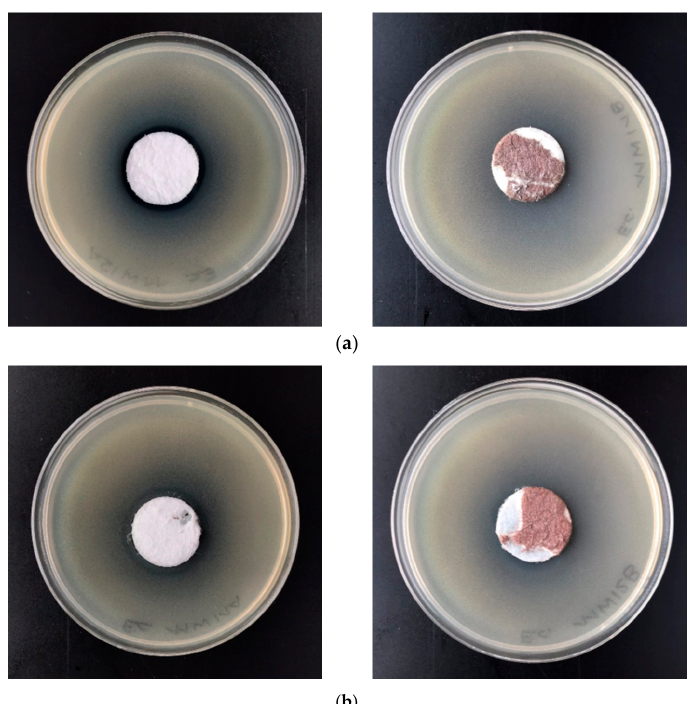
Figure 6. Inhibition zones of bacterial growth on Petri dishes, PLA–Cu 0 (10) sample: Escherichia Coli ( a ); Staphylococcus aureus ( b ).